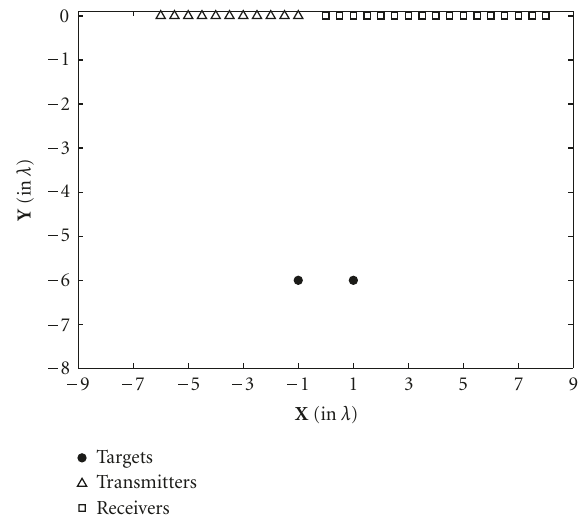
Figure 1: Geometry for the simulation in 2D space of subspace- based localization and inverse scattering of two